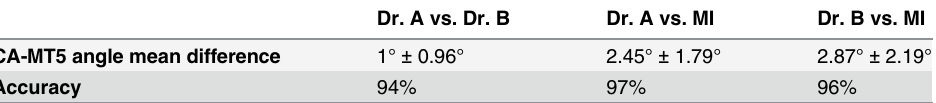
Table 2. Comparison of the difference in the CA-MT5 angle among radiologists A, B, and the MI regis- tration algorithm.